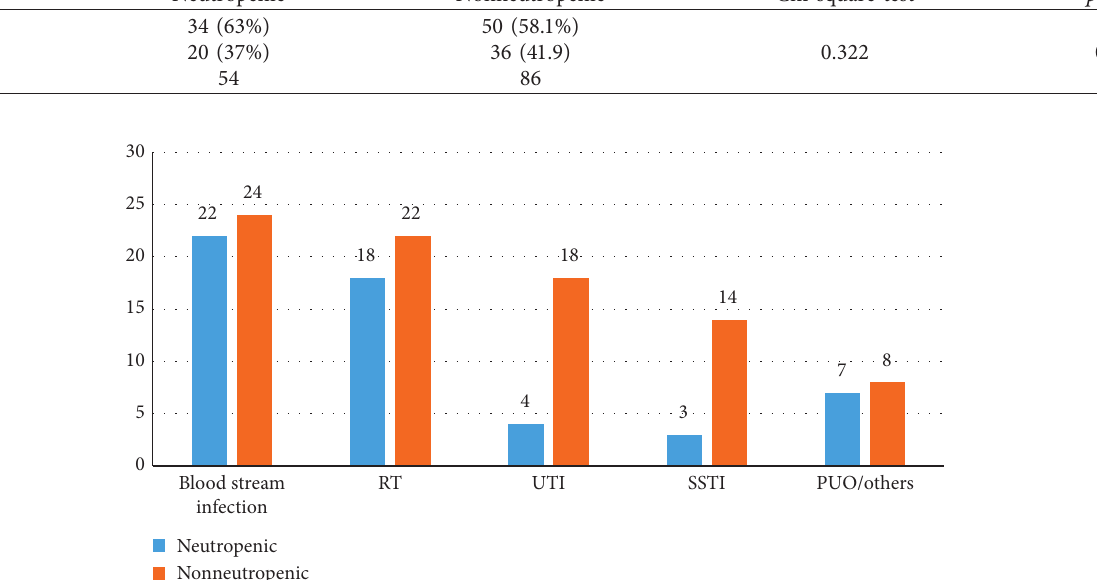
Table 5: Association of neutropenia with outcome (% is within neutropenic and nonneutropenic episodes). Outcome